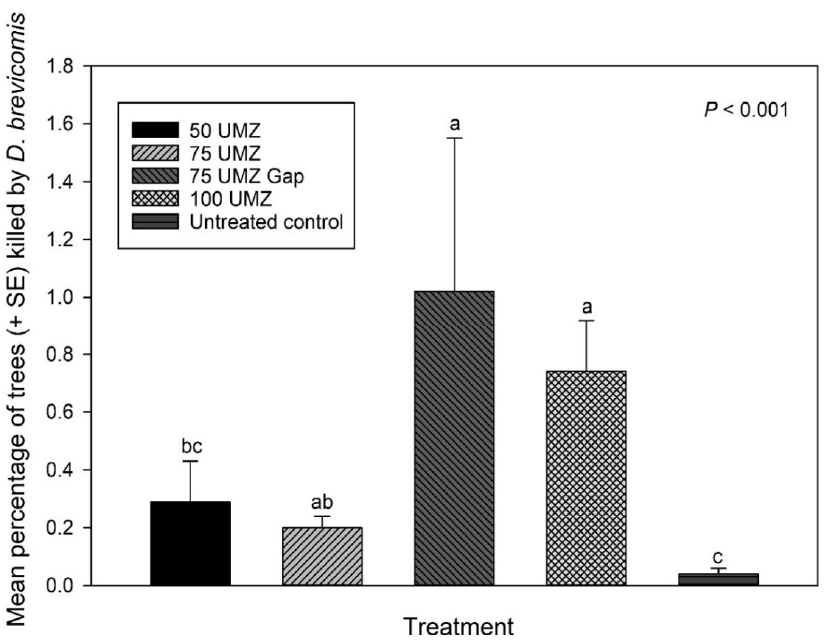
Figure 4. Mean percentage (+SE) of ponderosa pine ( Pinus ponderosa ) killed by western pine beetle ( Dendroctonus brevicomis ) following thinning and prescribed burning at Pringle Falls Experimental Forest, Oregon. Means (+SE) followed by the same letter are not significantly different ( p > 0.05).